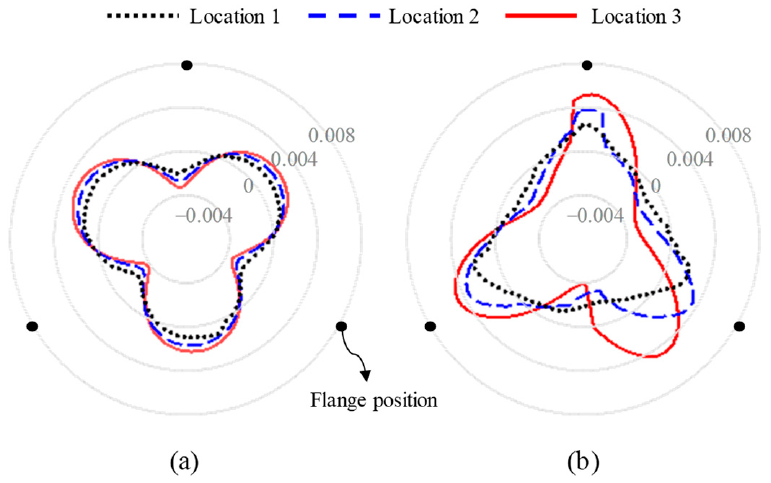
Figure 14. Roundness of the outer ring raceway according to the location: ( a ) inboard row and ( b ) outboard row.